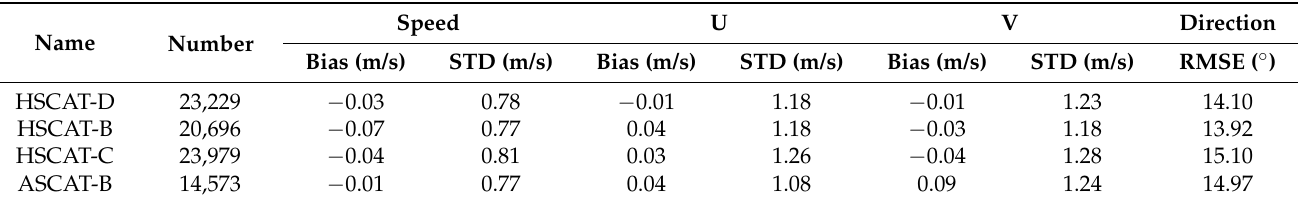
Table 2. Statistics of comparisons between scatterometer wind and buoy wind.